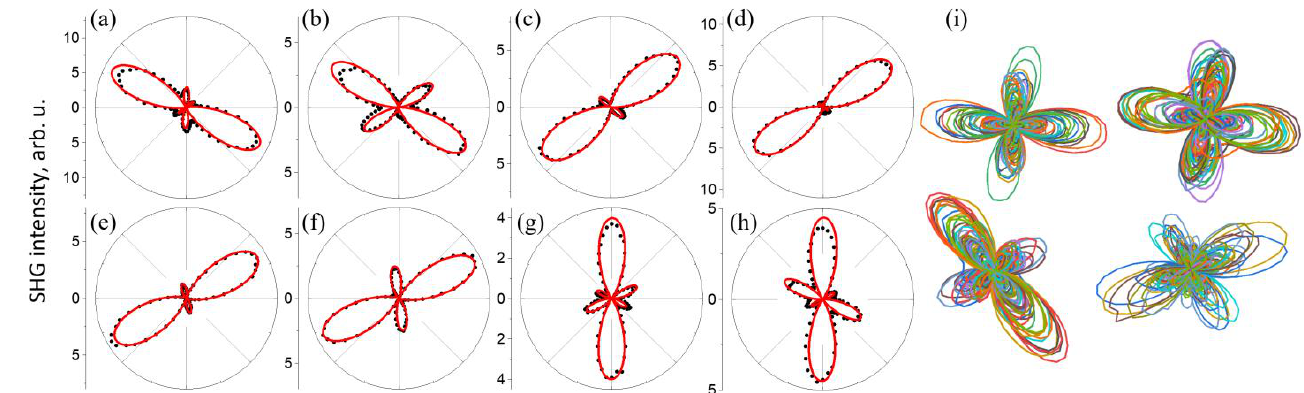
Figure 4. Azimuthal dependencies of the SHG intensity in different areas of the spherulite (polar coordinate of the area: ( a ) — 0°, ( b ) — 40°, ( c ) — 80°, ( d ) — 120°, ( e ) — 160°, ( f ) — 200°, ( g ) — 240°, ( h ) — 280°). The dots show the experimental data, the lines show the fitting. ( i ) — Sets of experimental azimuthal dependences of four different spherulites. Each set consists of 72 azimuthal dependences, which correspond to 72 areas of one spherulite, located on one circle as showed in Figure 3. Silicon substrate.